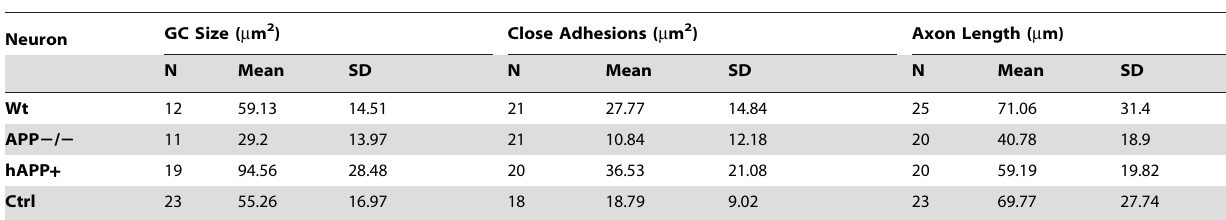
Table 1. GCs on Laminin, Numerical Data.